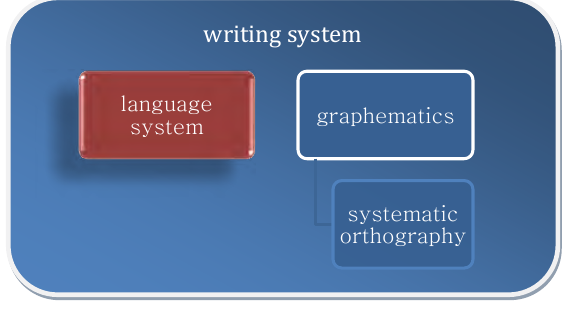
Figure 4: Structure of the writing system (orthographic